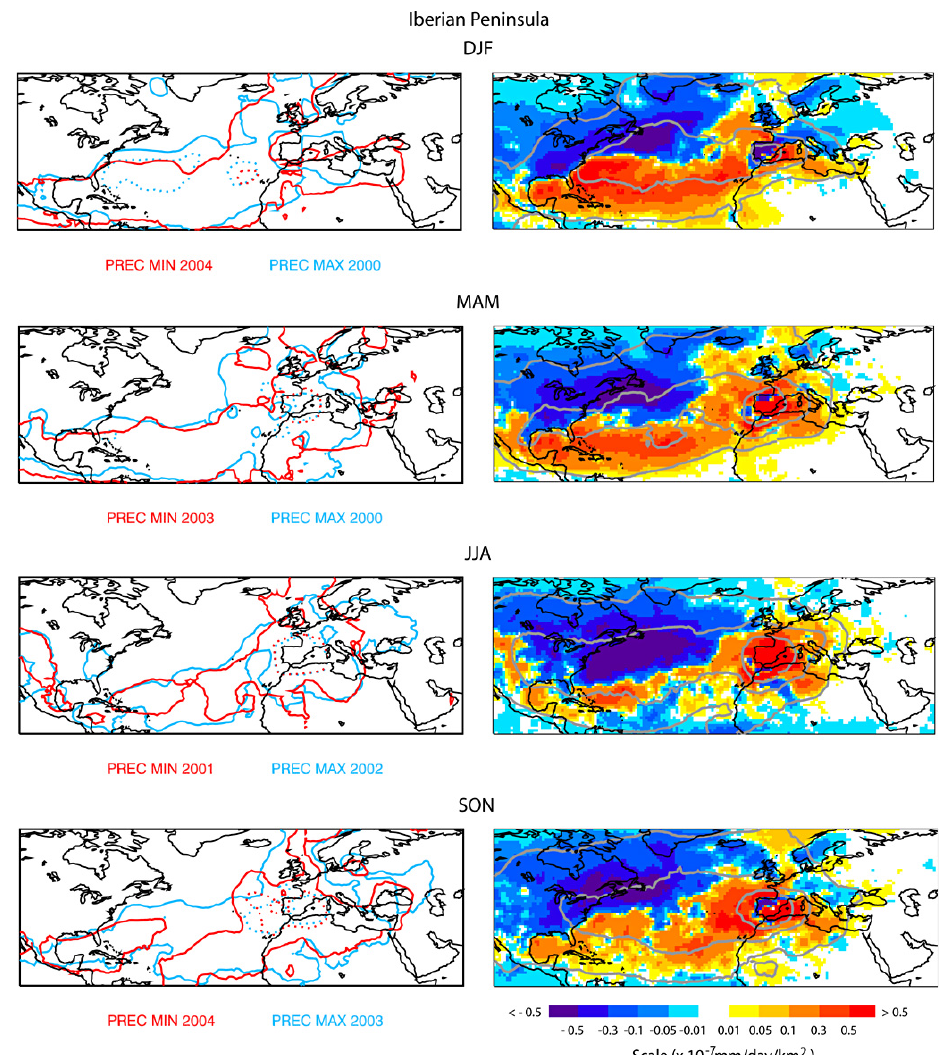
Fig. 2. (left-hand panels): Seasonal backward analysis for the Iberian Peninsula (IbP) using 10-day retrointegrated average values of ( E − P ). The values were normalized by the area of the target region (618945km 2 ) showing contours of 0.01 × 10 − 7 mmday − 1 km − 2 (solid lines) and 0.5 × 10 − 7 mmday − 1 km − 2 (dotted line) observed for the selected wetter (blue lines) and drier (red lines) years (indicated below each figure); (right-hand panels): seasonal 10-day retro-integrated average values of ( E − P ) normalized by the area of the target region for 2000–2004 (shaded, by 10 − 7 mmday − 1 km − 2 ) and variance (grey contour lines of 0.01, 0.1 and 0.5 × 10 − 14 mm 2 day − 2 km − 4 )